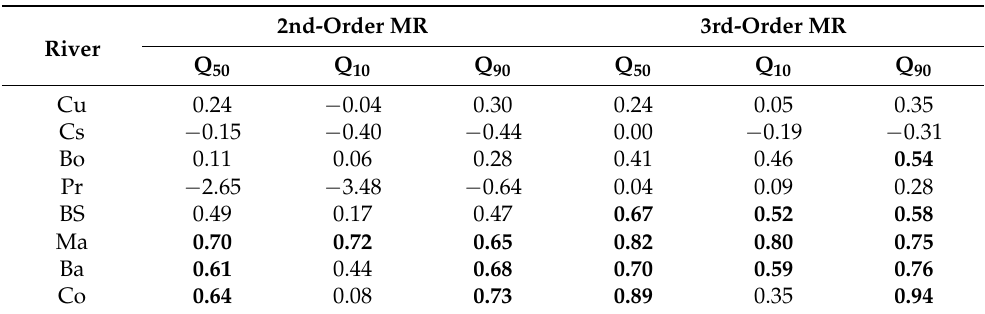
Table 4. KGE for the models using Niño 3.4–DMI as predictors in SON a set. The values higher than 0.5 are bolded, indicating good model skill.